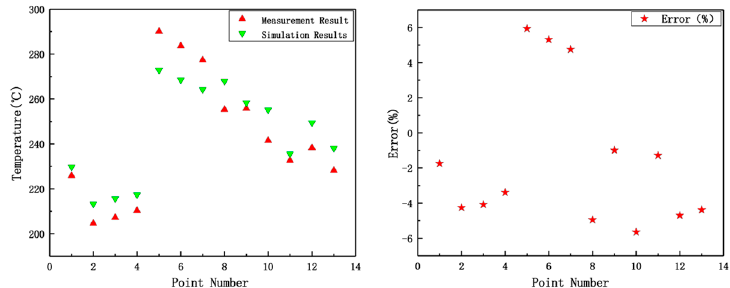
Figure 10. Comparisons between the simulations and measurement results.